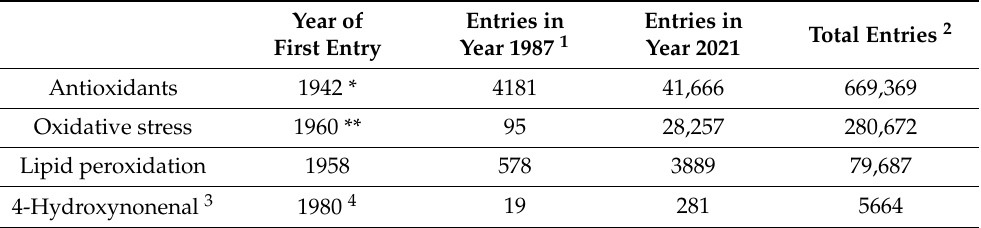
Table 1. Publication metrics on selected terms Listed in the PubMed